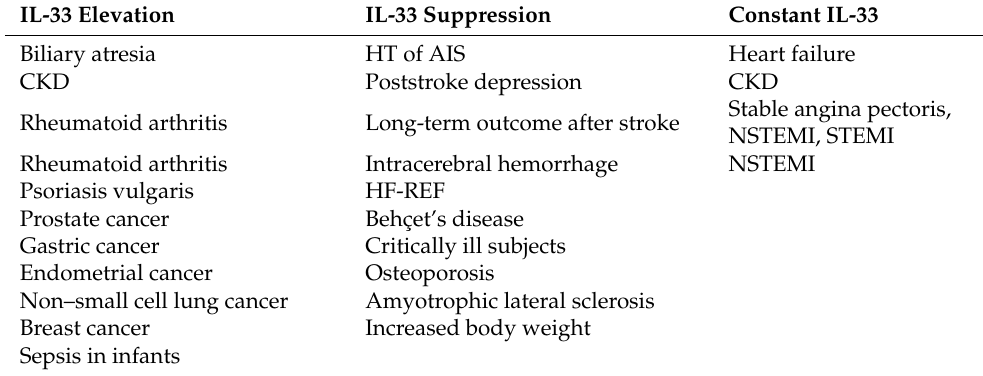
Table 1. Studies in serum IL-33 in inflammatory and noninflammatory disorders. Reprinted with permission from J. Circulating Biomarkers,